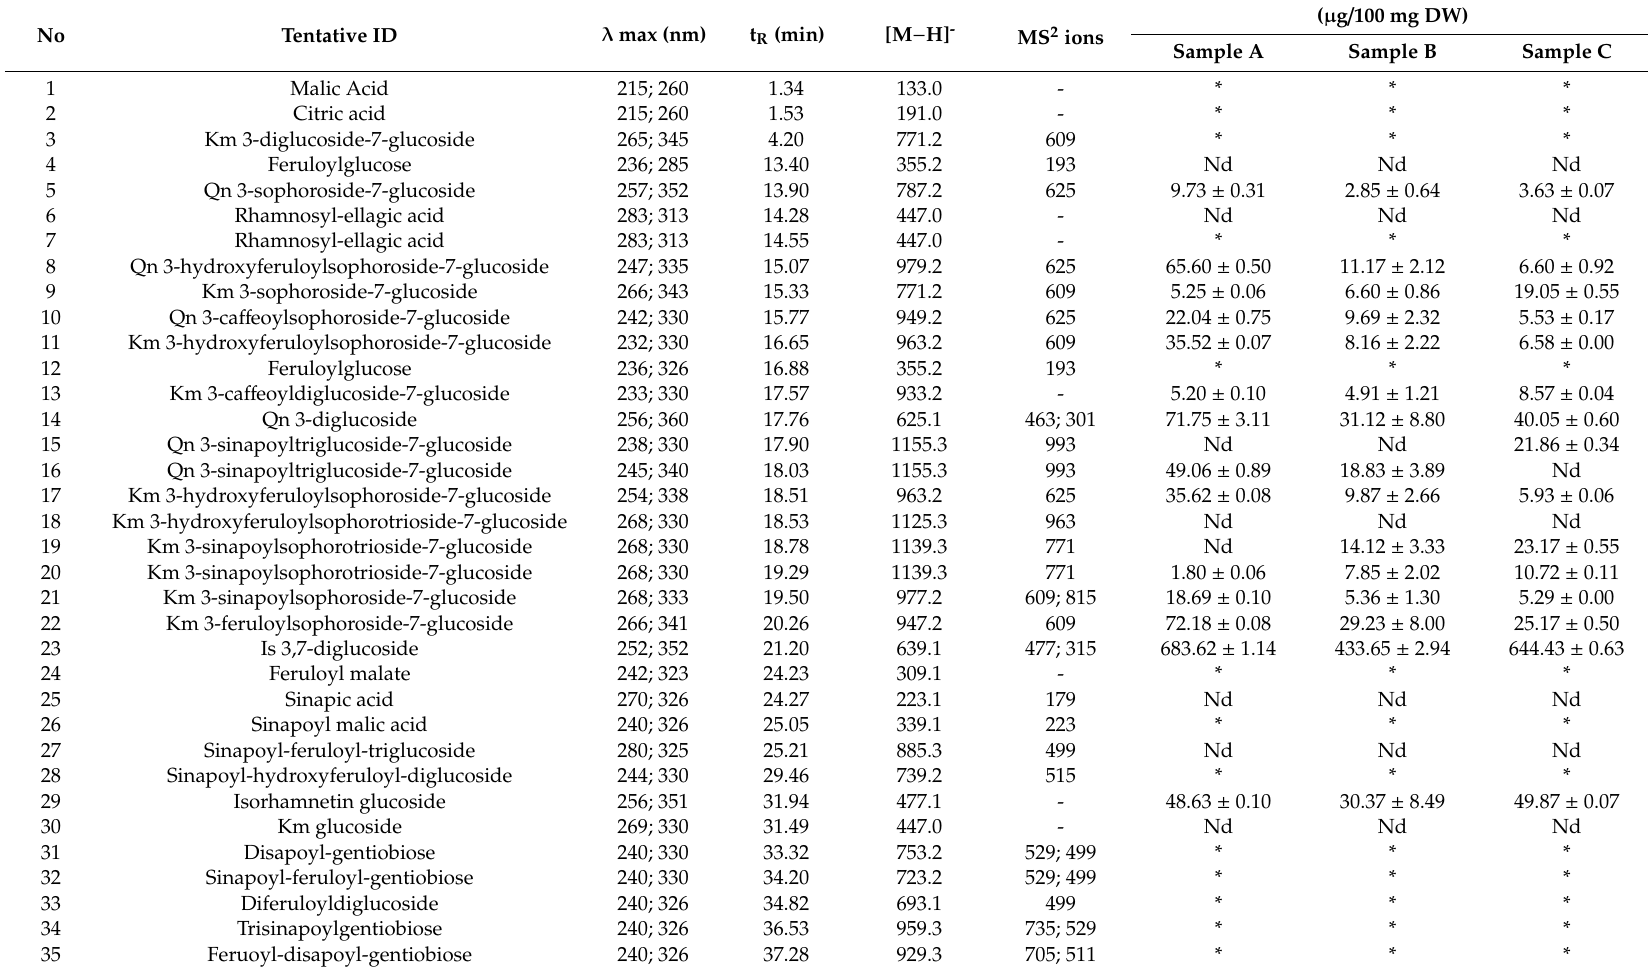
Table 1. Metabolite determination of the flowers extracts of the three B. juncea accessions using HPLC-PDA-ESI-MS /